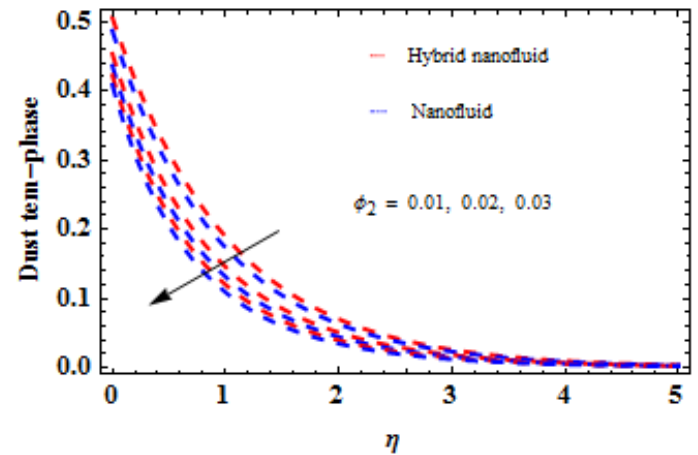
Figure 14. Influence of 𝜙 2 via dust temperature.